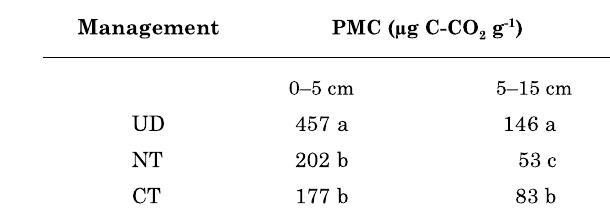
Table 3. Potential mineralizable carbon (PMC) in different layers of undisturbed (UD), untilled (NT) and conventionally tilled (CT) soils. Statistically different (p < 0.05) means are indicated by different letters in the same column